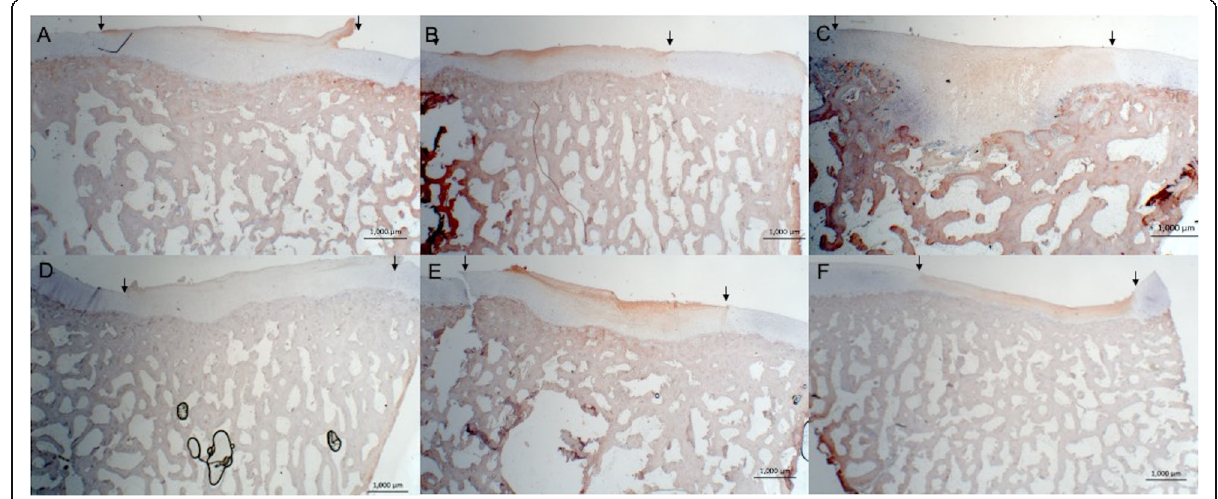
Fig. 8 Collagen I staining; scale bar 1000 μ m. Magnification 12.5-fold. Defects treated with CB ( a - c ) and BMS ( d - f ). Images represent 0 – 25% (left),